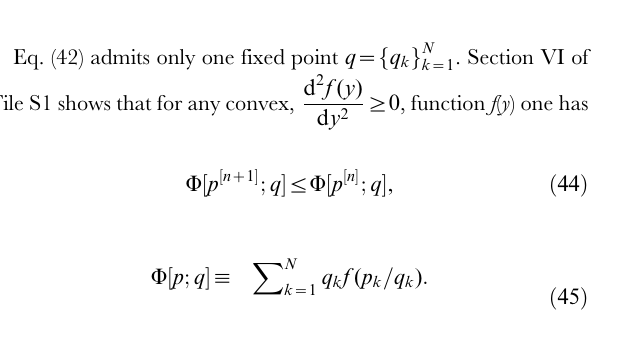
, it is possible to make it a local (or even the global) tail of f p k g N k ~ 1 provided that E is not close to 1. maximum of f ~ pp k g N k ~ 1